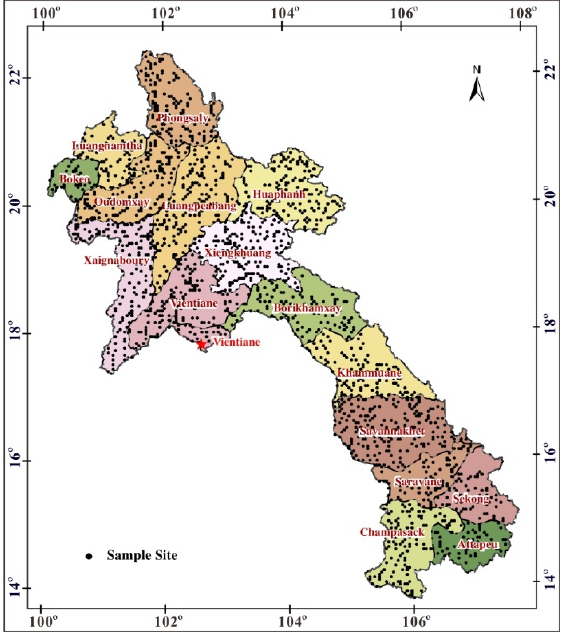
Figure 3. Sample sites of the National-scale Geochemical Mapping Project of Lao PDR (NGMPL).